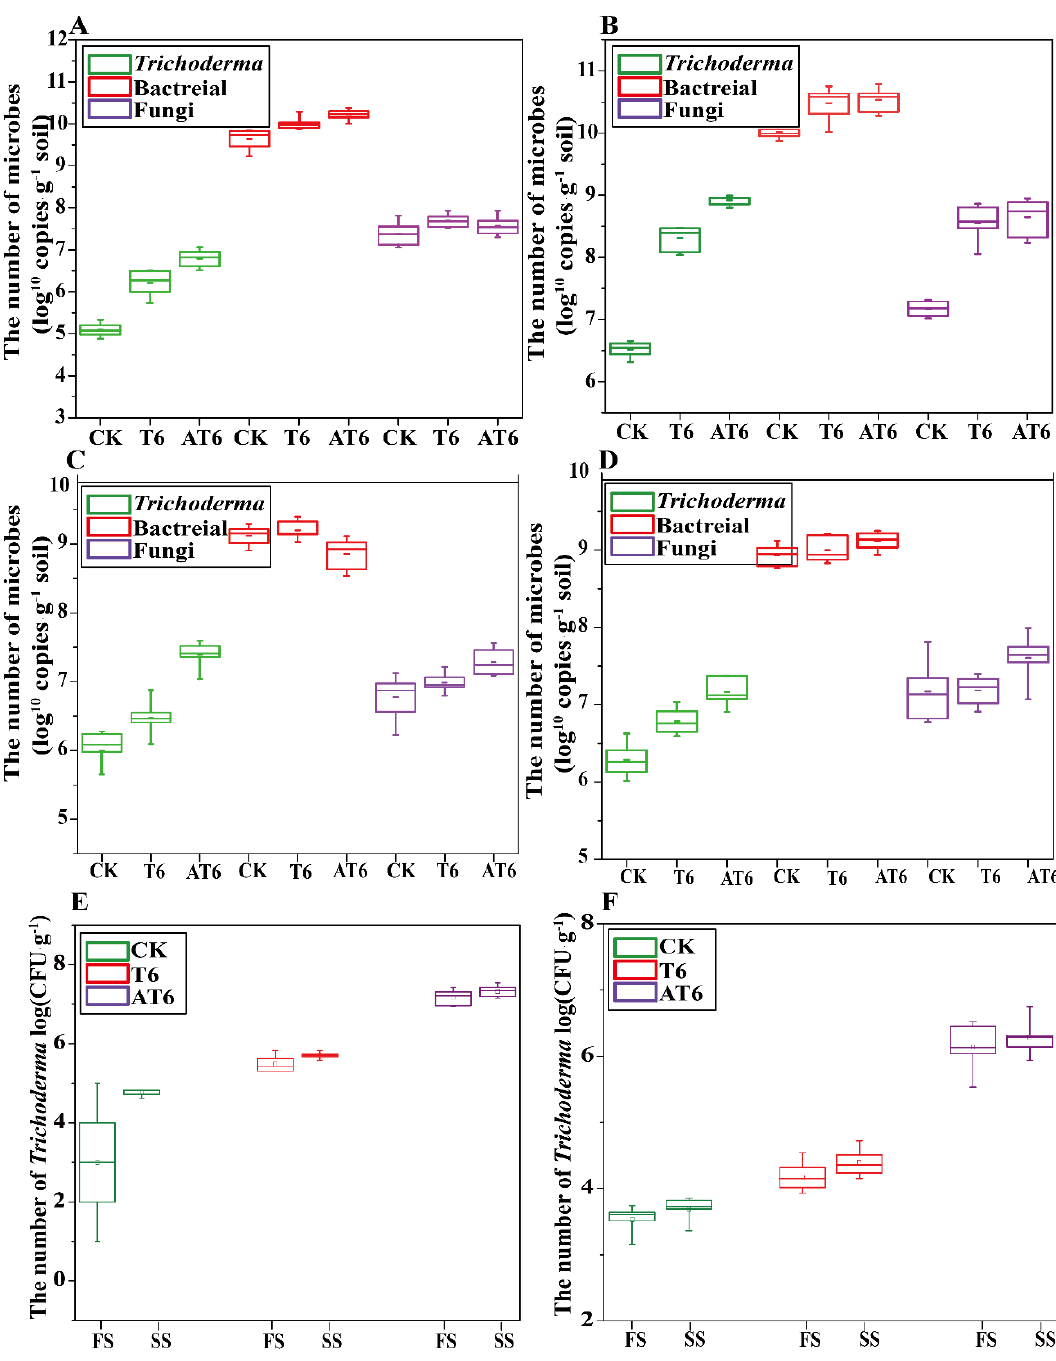
Figure 6. The quantification of total bacteria, fungi, and Trichoderma spp in the plant root rhizospheres of different treatments. ( A , B ) are the quantification results of total bacteria, fungi and Trichoderma spp. in sandy soil during the FS and SS, respectively; ( C , D ) are the quantification results of total bacteria, fungi and Trichoderma spp. in sandy soil during the FS and SS, respectively; ( E ) the numbers of culturable Trichoderma spp. in CK, T6 and AT6 in the sandy soil during the FS and SS; ( F ) the numbers of culturable Trichoderma spp. in CK, T6 and AT6 in the mountain soil during FS and SS.